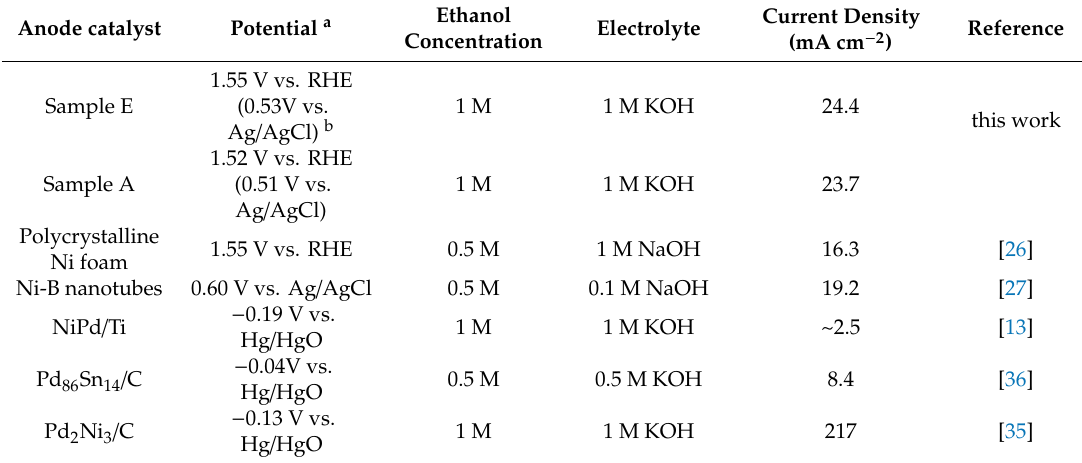
Table 2. Reported current densities from cyclic voltammograms of alkaline ethanol electrooxidation on various catalysts in the